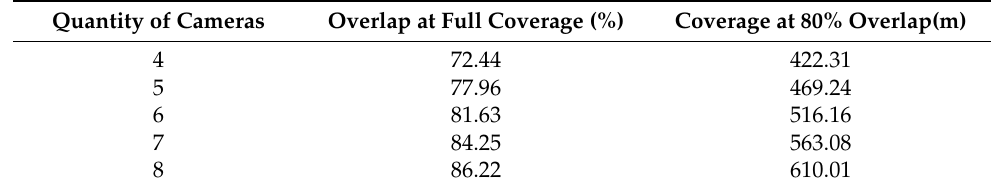
Table 4. Overlap and coverage length for different quantity of cameras.